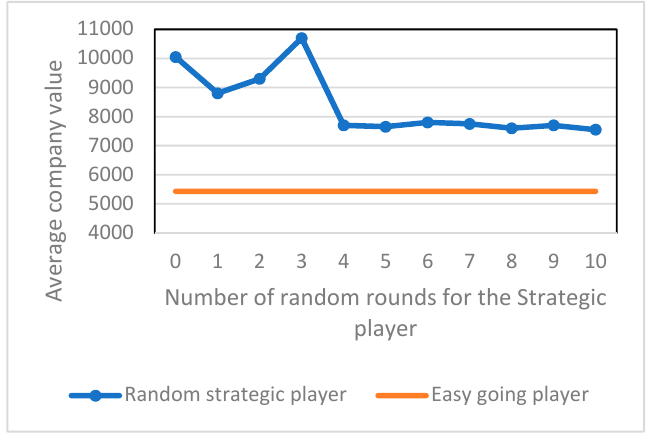
Figure 7. Average company value of Strategic player .